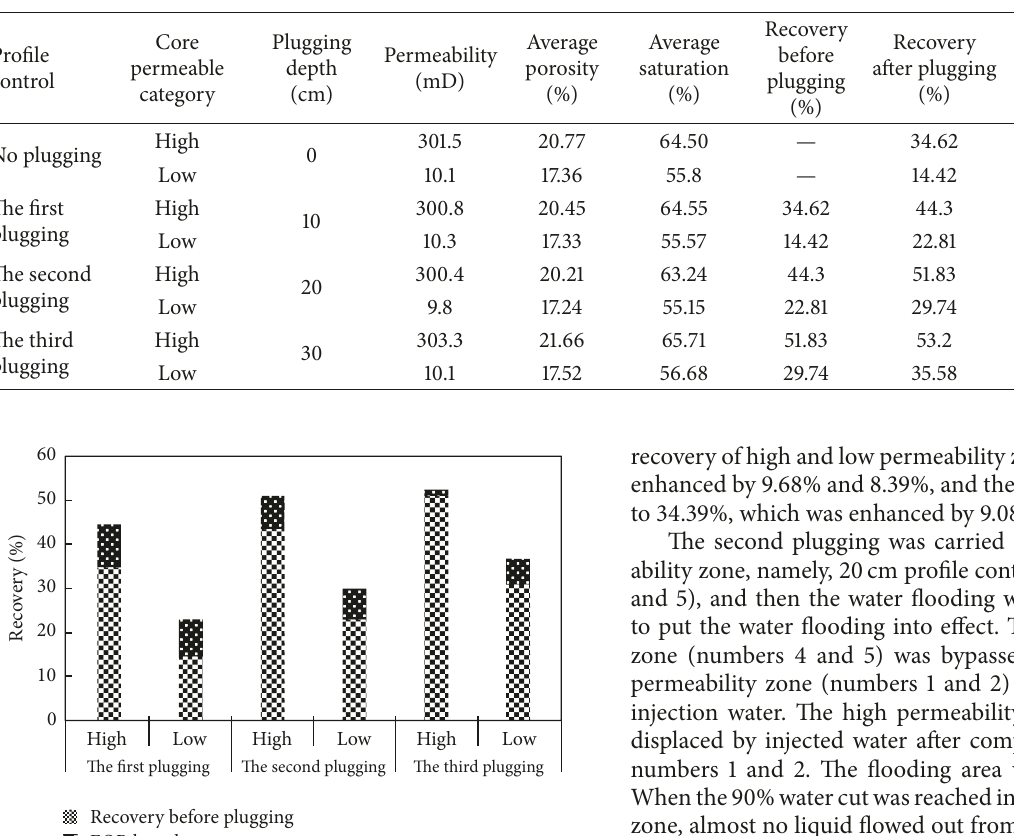
Table 5: The results of oil displacement experiment in different plugging depth.